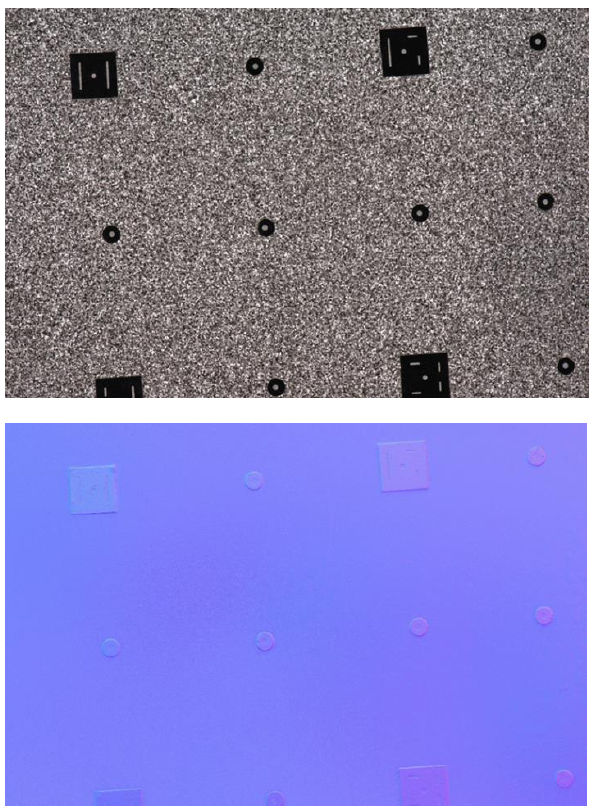
Figure 7. (Top) Albedo image of aluminium reference plate. (Bottom) Per-pixel surface normal map of aluminium reference plate colour-coded with R,G,B channels representing X,Y,Z normal components.